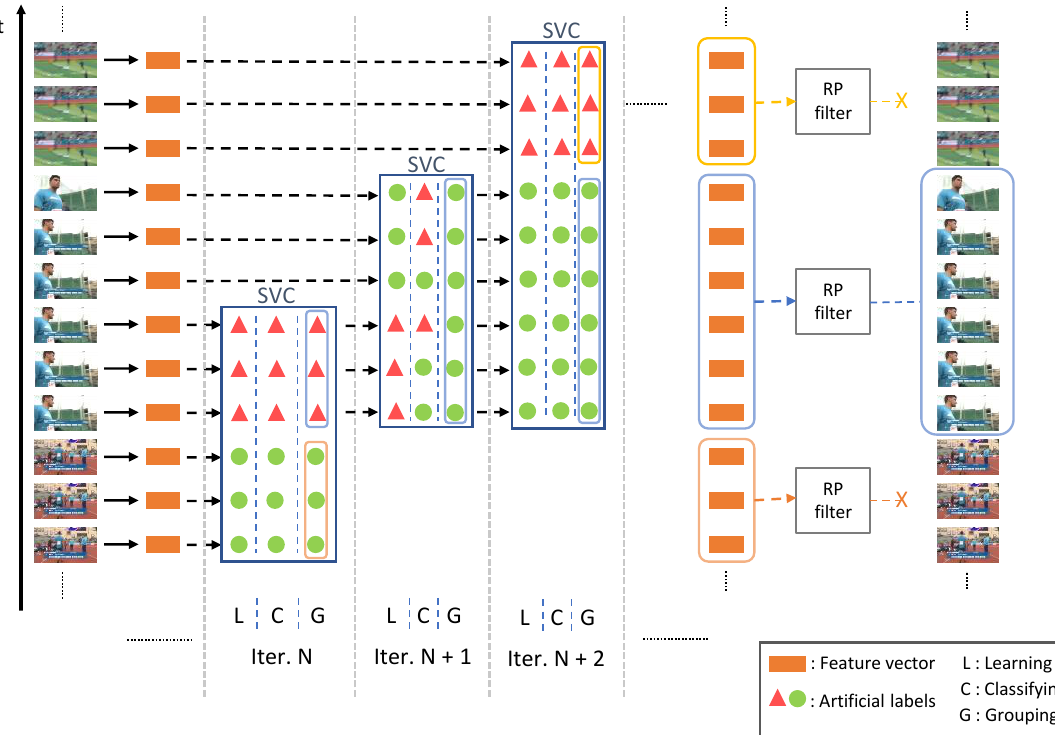
Figure 3. Unsupervised action proposals generation process. At each iteration, the SVC module is, first, fed with a certain number of contiguous frame features. Afterwards, they are artificially labeled for the learning step of the SVC module (note that the labels are artificial, independent at each step and do not correspond to any actual category). Finally, the SVC will decide on which groups to make after evaluating the classification error. A high value means that the features are not easily separable and, thus, they belong to the same segment. Conversely, features are considered from different groups when the SVC is capable of separating them. The rank pooling module will determine whether the candidate segments generated by the SVC are actual proposals. The model operates completely online, accessing only to the video frames available until time t